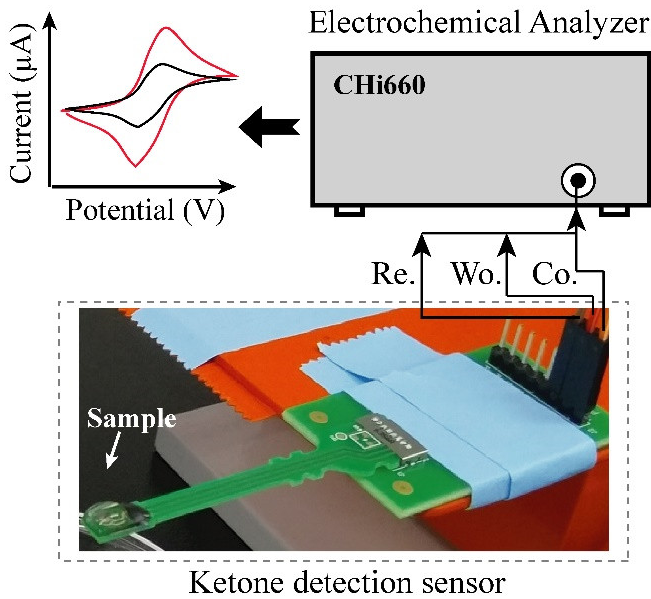
Figure 2. Layout of experimental set-up. Urine sample was dispensed on the electrode and cyclic voltammetry measuring (CV) was performed by connected CHI 660E.